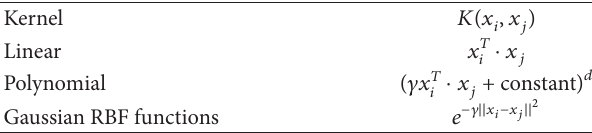
Table 1: Formulation of Kernel